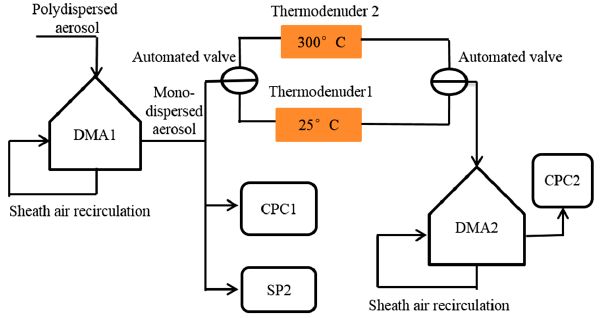
Figure 1. Schematic of the instrument